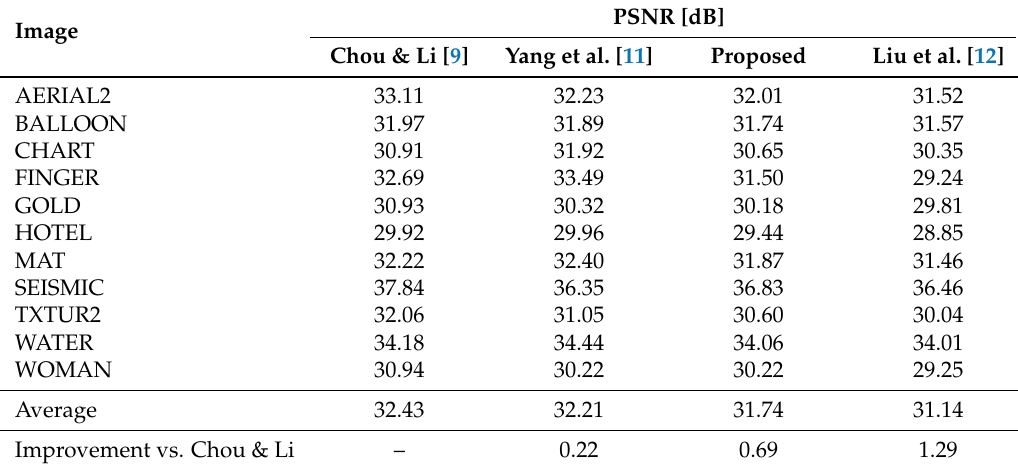
Table 2. Performance comparison of different JND models for measuring the visual redundancy in test images based on PSNR values of JND-contaminated